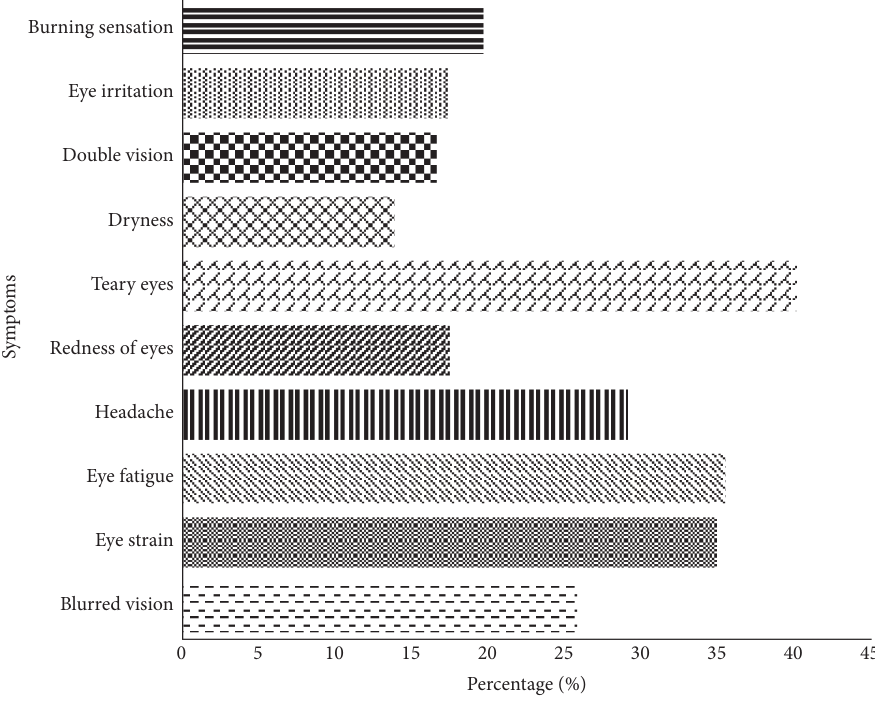
Figure 1: Summary of CVS symptoms reported by study